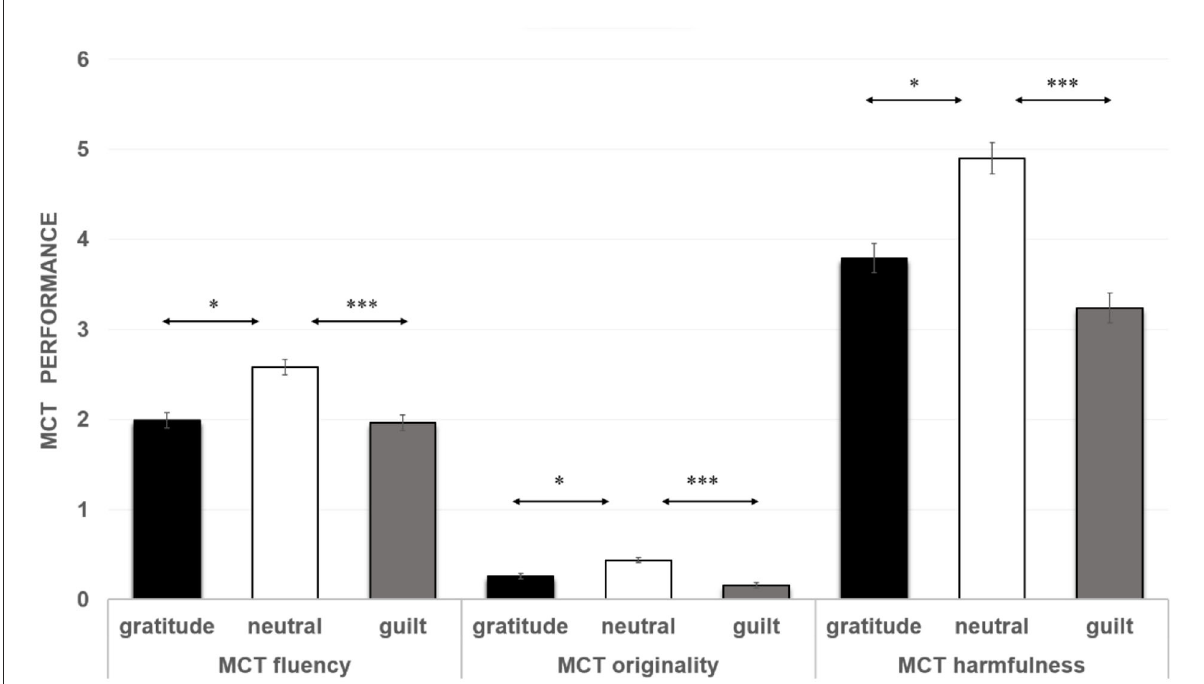
FIGURE1 Malevolent creativity task performance in different emotion groups in experiment. The error bars represent standard errors. * p < 0.05, *** p < 0.001